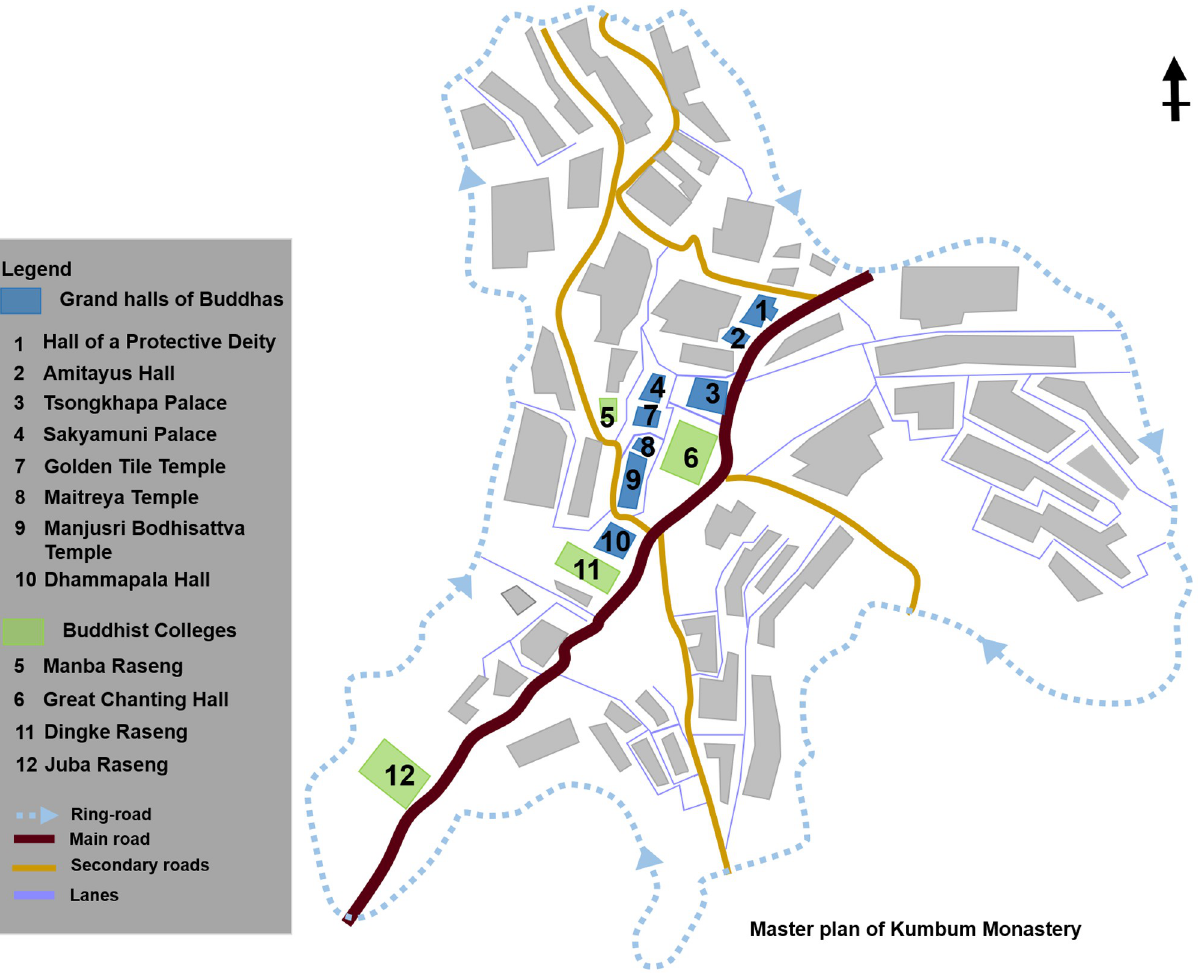
Fig 2. Distribution of case